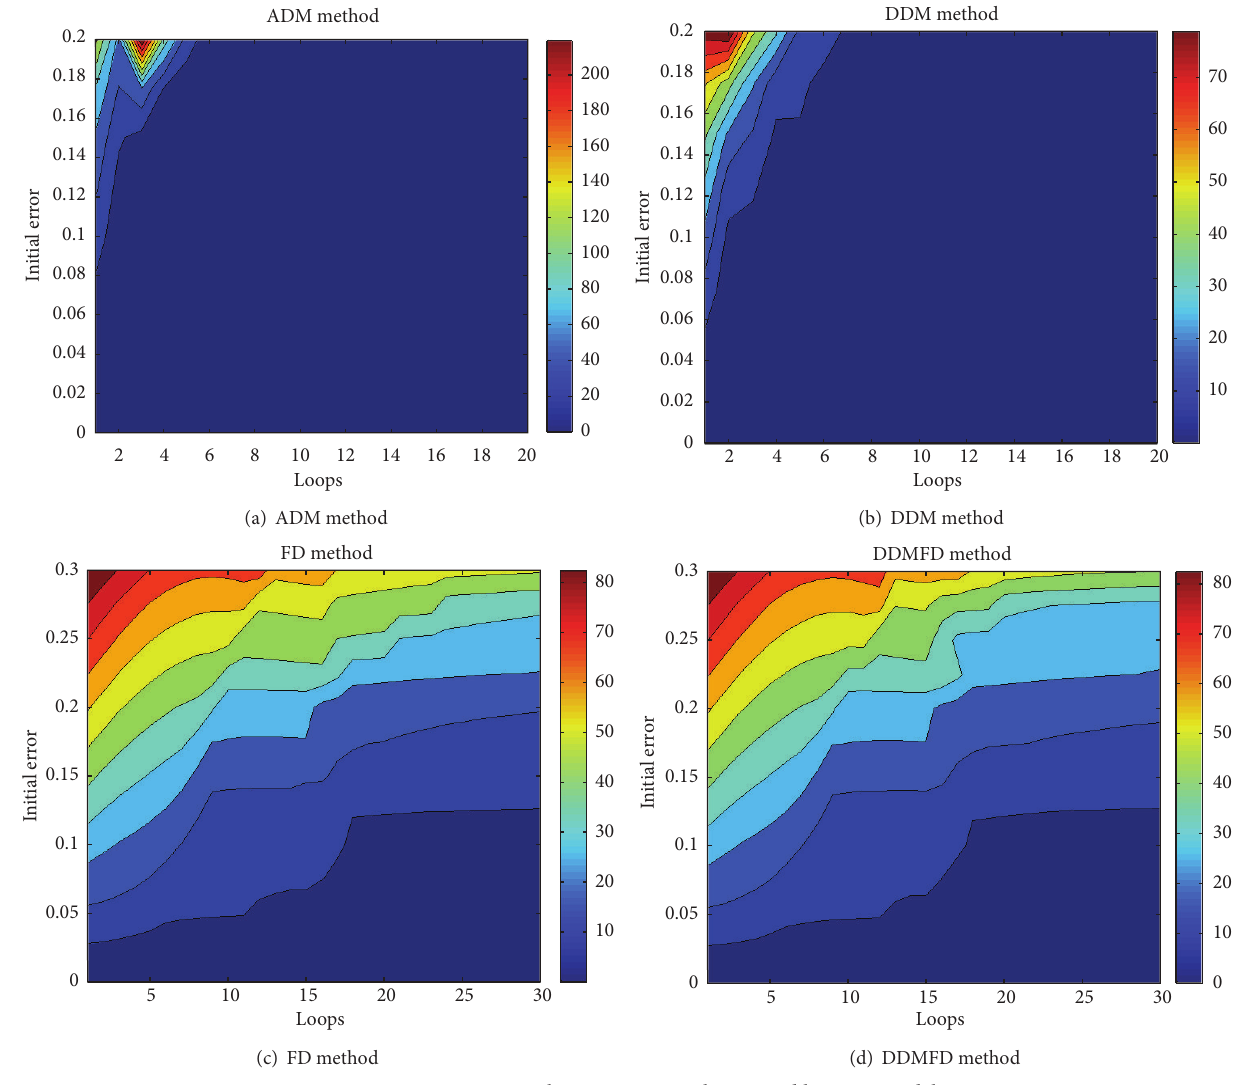
Figure 4: RPE contours with respect to initial error and loops in model